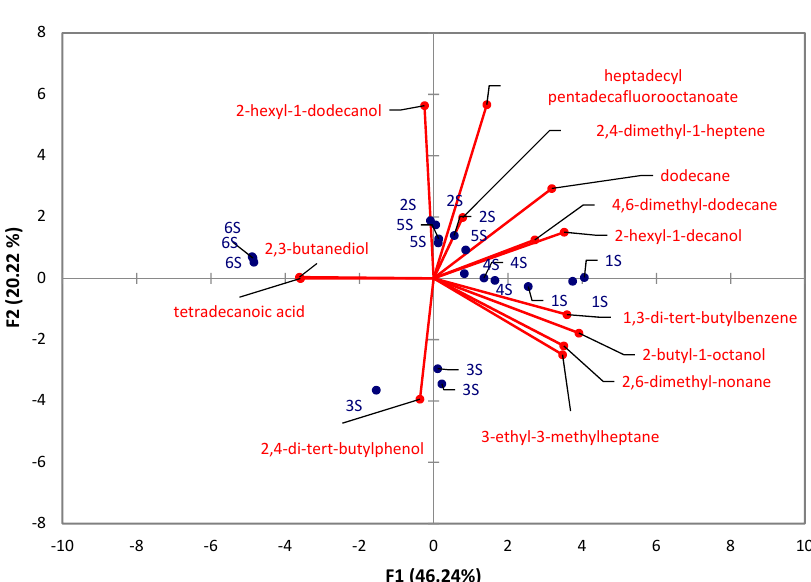
Figure 4. PCA evaluation of six developmental stages (1S–6S) of A. rubescens Pers stipes.